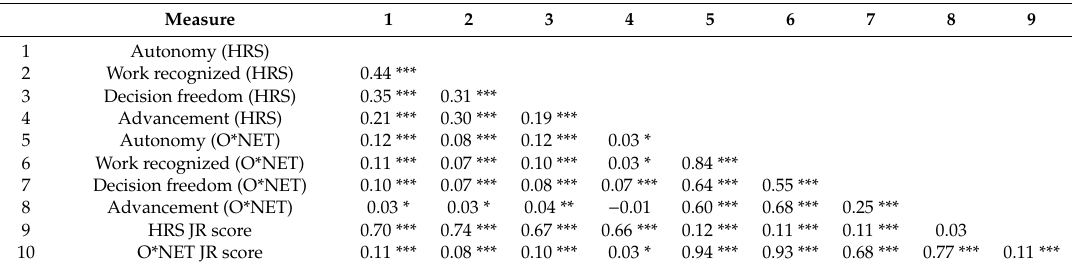
Table 3. Correlations between HRS and O*NET job resource variables and job resource composite